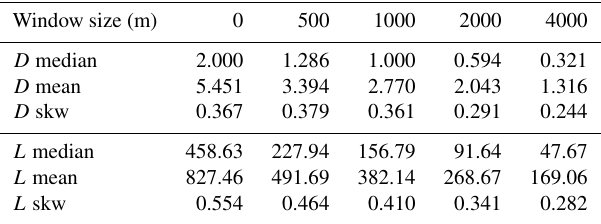
Table 2. Median and mean of depth to bedrock D (m), and horizon- tal distance to outcrop L (m), for raw observations (window size = 0m) and declustered data with window [ 500 ; 1000 ; 2000 ; 4000 ] m. The skewness index is skw = median/mean.